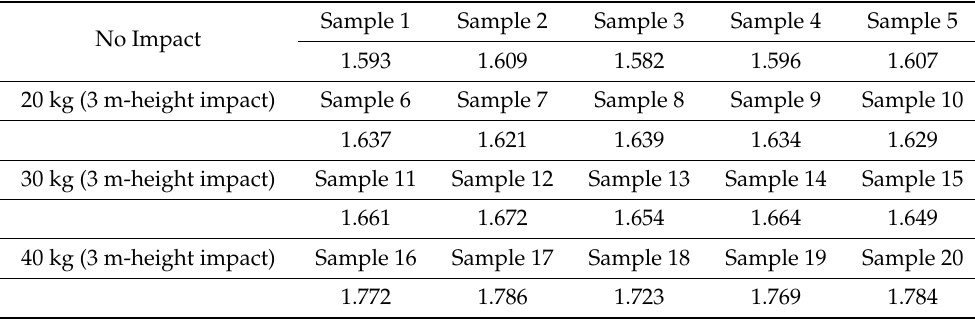
Table 3. The fractal dimensions of all unburned concrete samples.